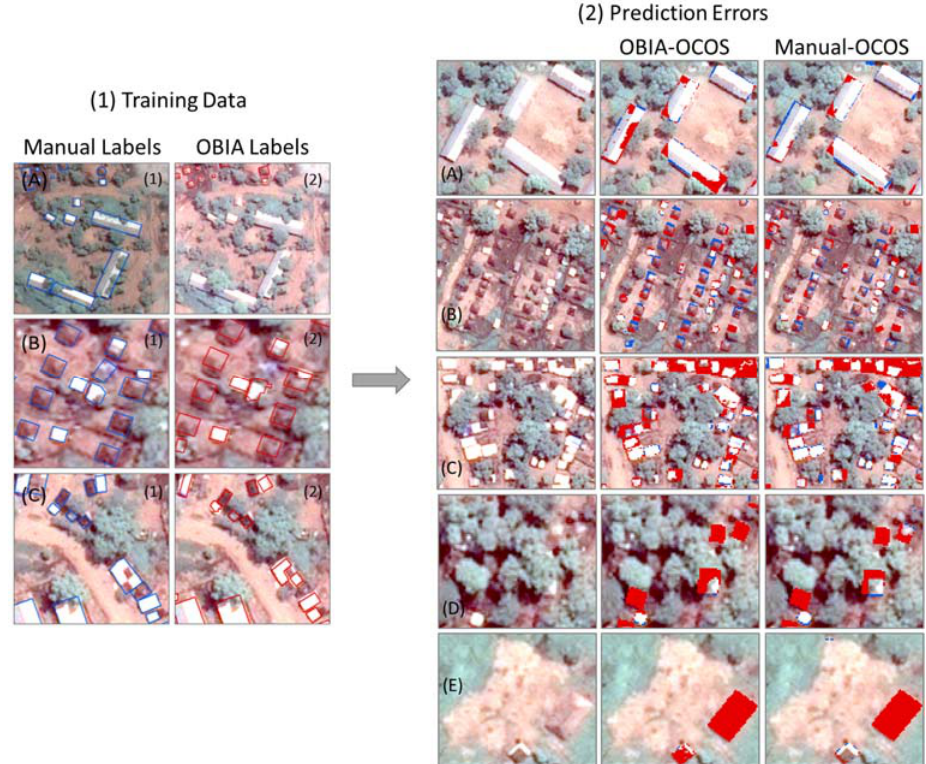
Figure 9. ( 1 ) The annotated errors in the original OBIA labels and ( 2 ) examples ( A – E ) showing the differences in FP (blue) and FN (red) pixels between the OBIA ‐ OCOS model (middle) and the Manual ‐ OCOS model (right) from the Kule Wet case.